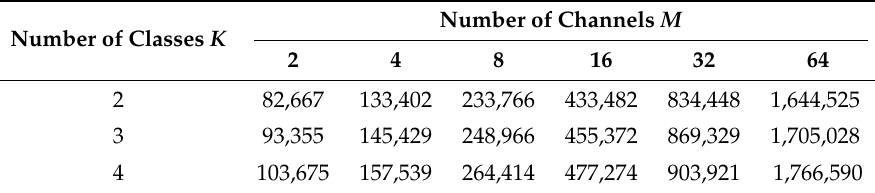
Table 3. The area ( µ m 2 ) of the proposed circuit for different numbers of channels M and classes K .